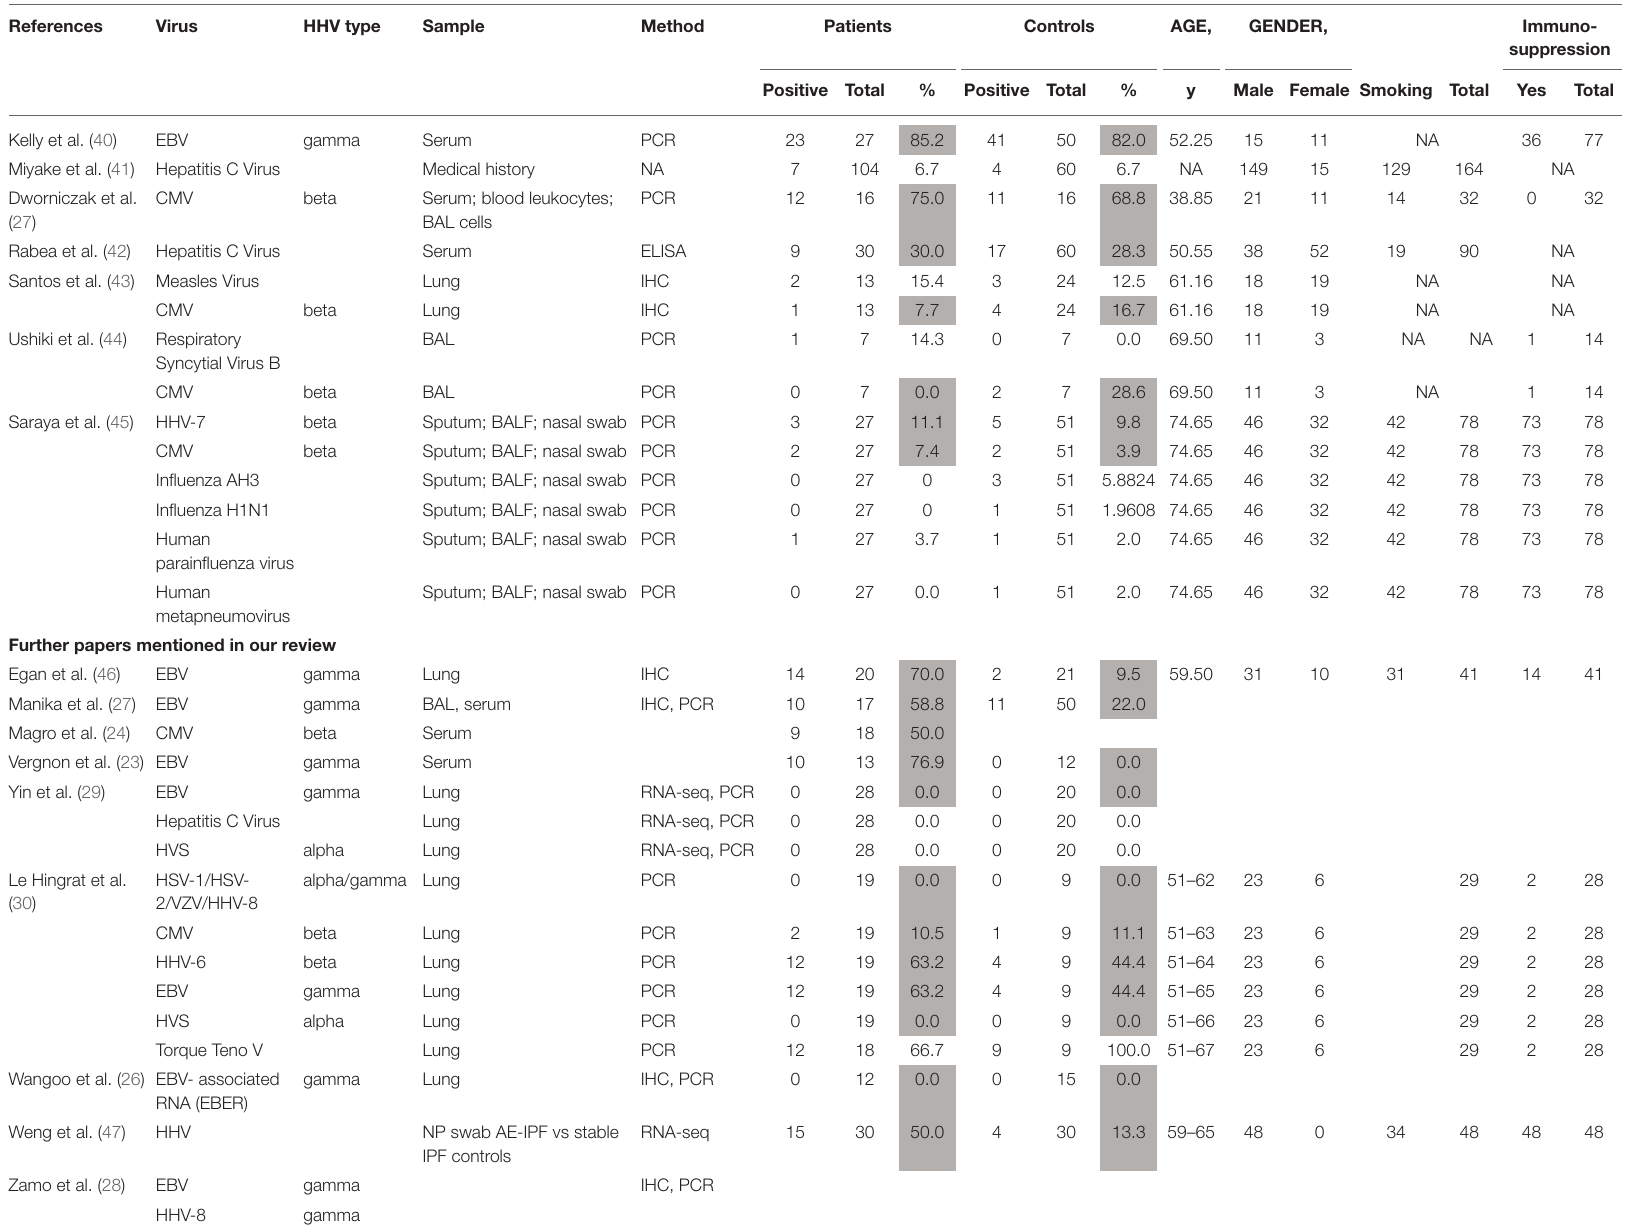
Grey shading highlights those studies related to